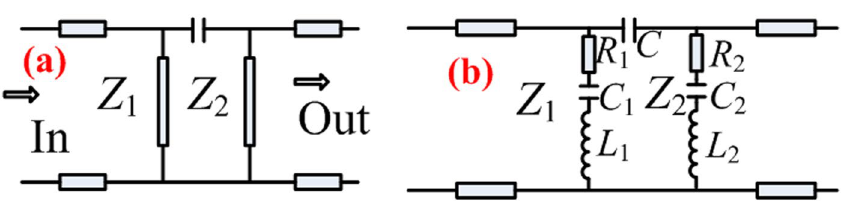
Figure 5. Transmission line equivalent circuit of the designed